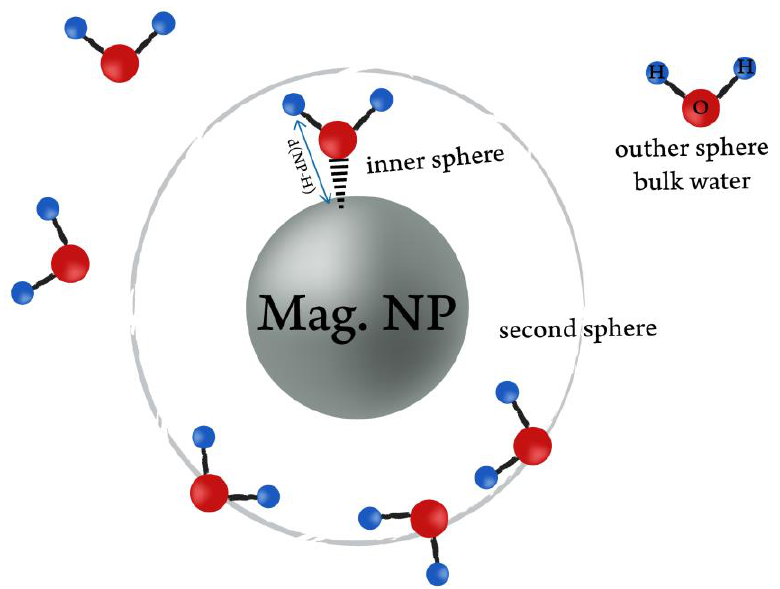
Figure 1. Schematic representation of a three-sphere model for a magnetic nanoparticle (NP).